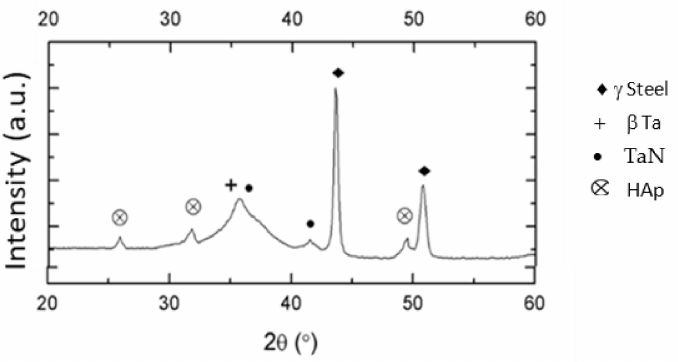
Figure 11. Grazing angle XRD of HAp deposited on